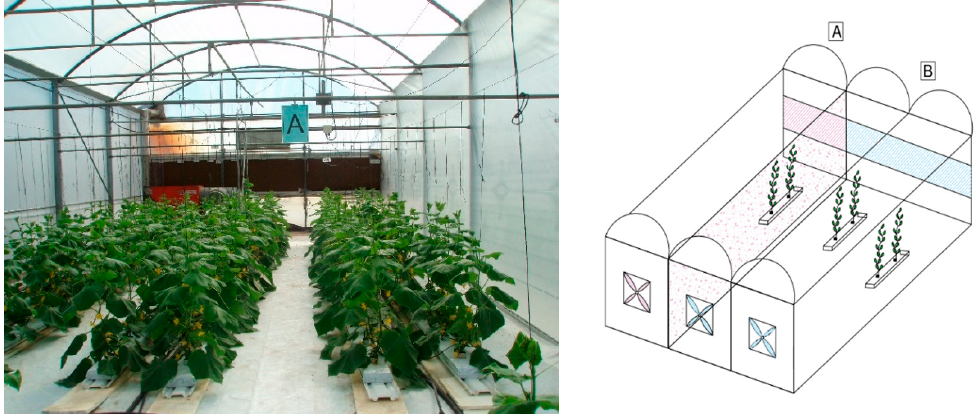
Figure 1. A photo of cucumber grown in the one greenhouse span ( left ); a greenhouse span ( right ) with a forced air ventilation (F V ) system (A) and a fan and pad evaporative cooling (F-P E ) combined with natural and forced air ventilation system (B).